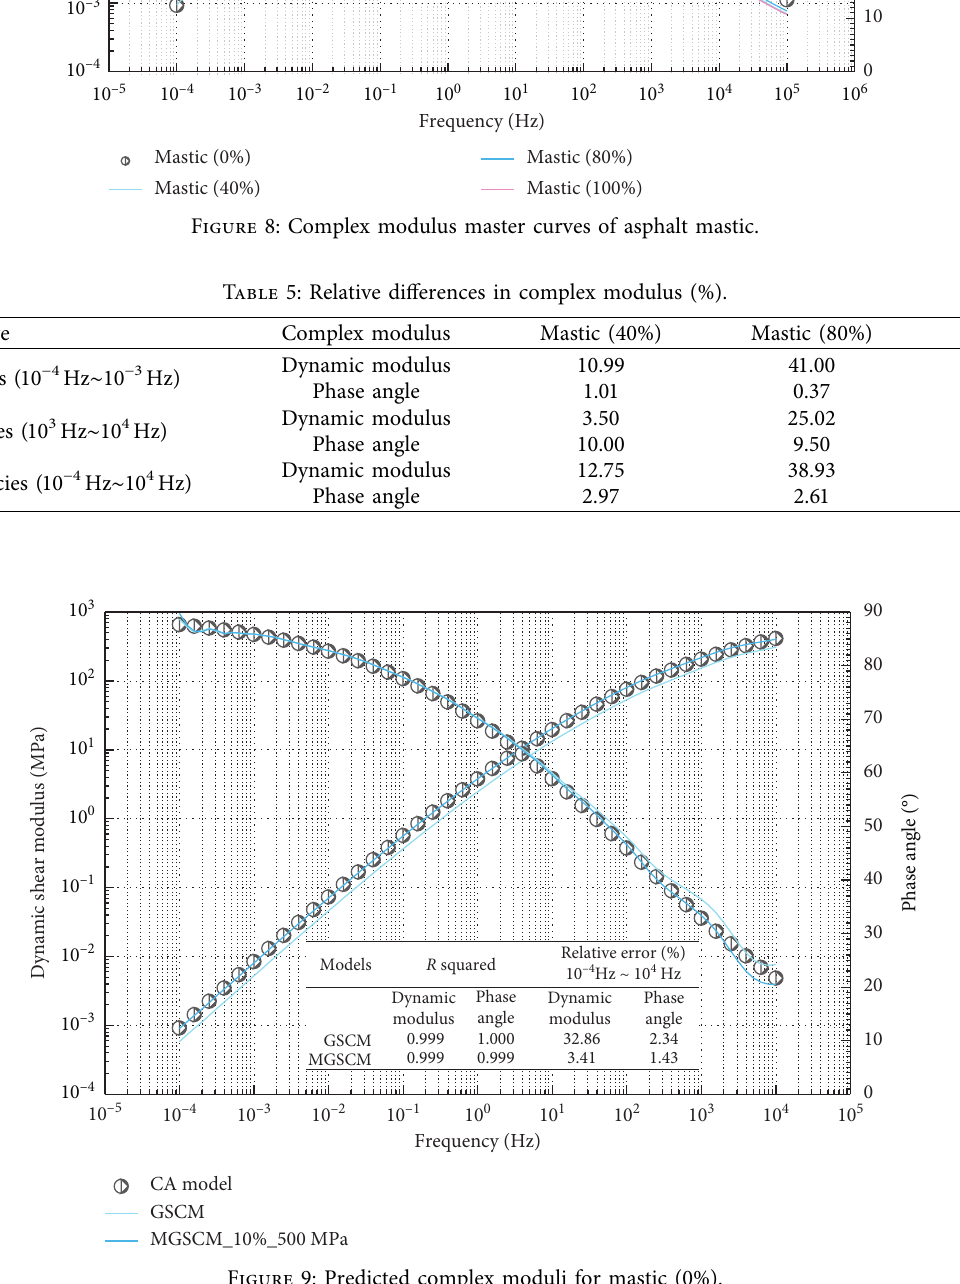
Figure 9: Predicted complex moduli for mastic (0%).